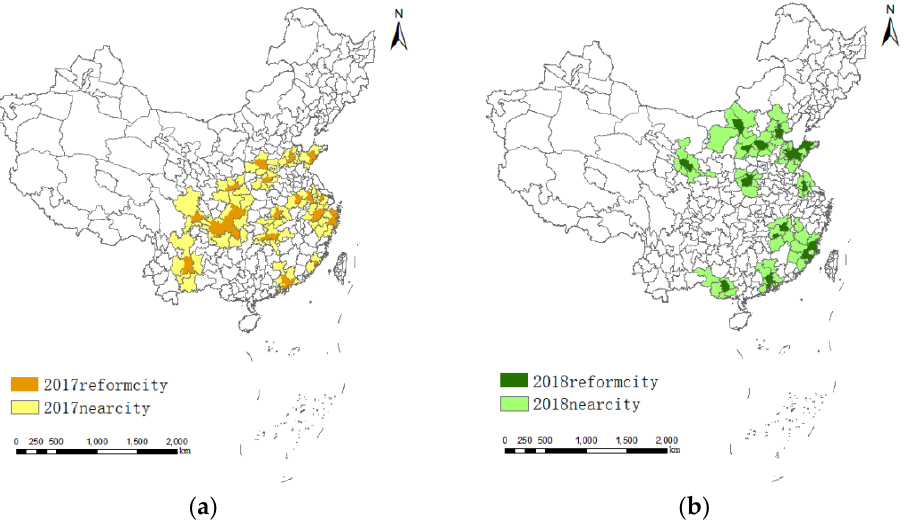
Figure 1. Talent policy implementation cities and its neighboring cities. ( a ) Implementation cities and its neighboring cities in 2017; ( b ) Implementation cities and its neighboring cities in 2018.